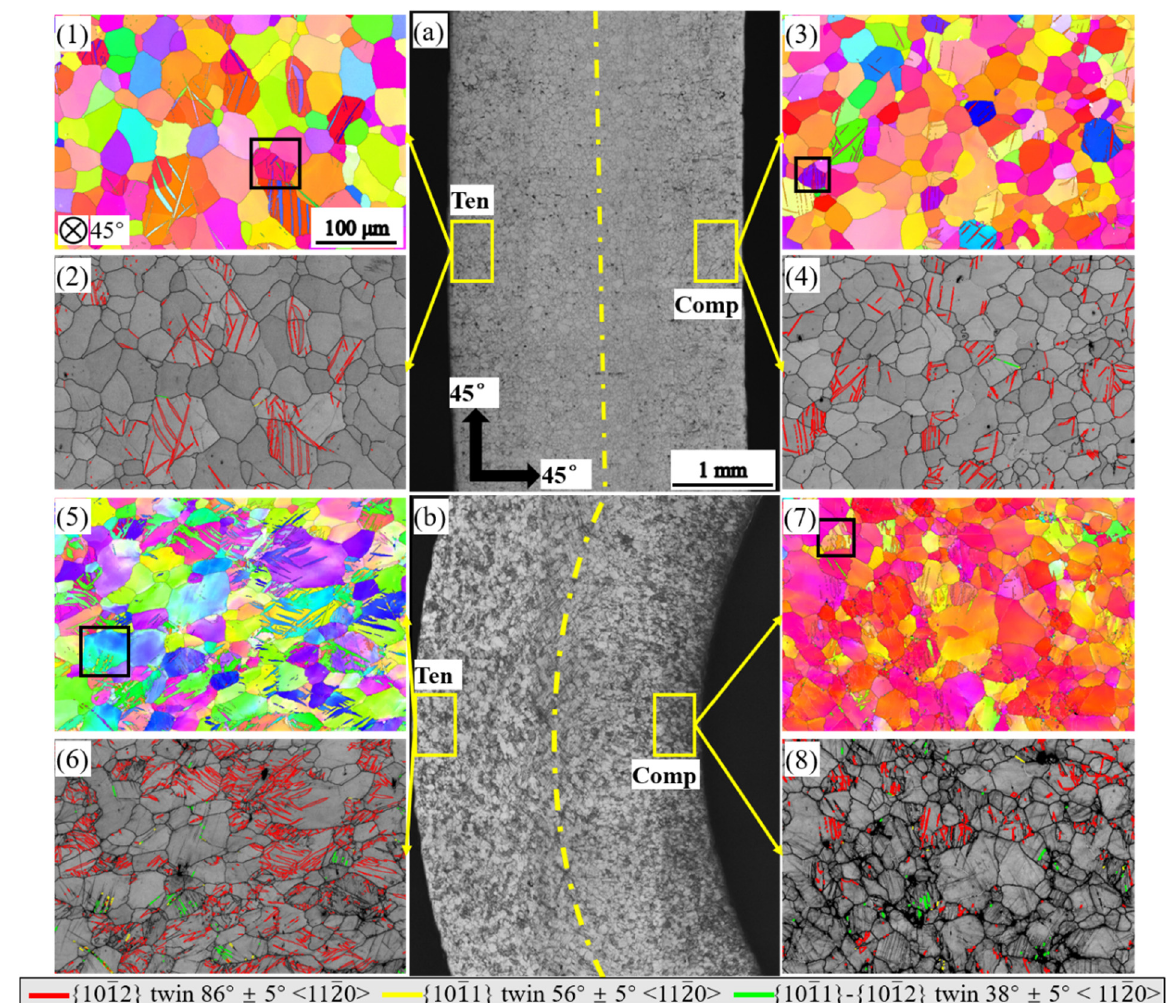
Figure 7. Microstructure of the 45° bending bar at a bending displacement of 3 mm and 12 mm: ( a , b ) optical micrograph of the bent sample; ( 1 , 3 , 5 , 7 ) inverse pole figures of the bent bar; ( 2 , 4 , 6 , 8 ) band contrast map of the bent bar with twinning boundary characterized.